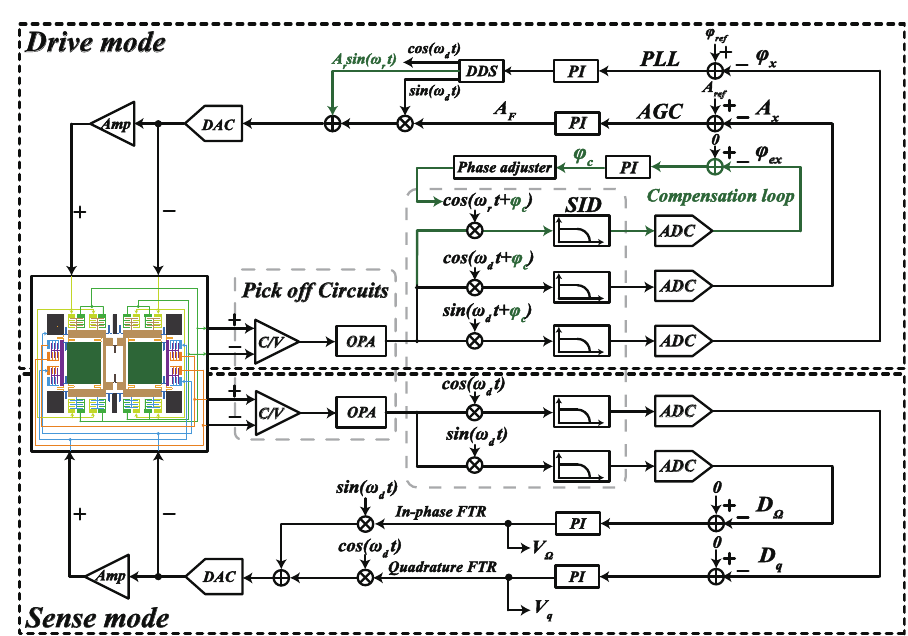
Figure 1. A block diagram of the digital control